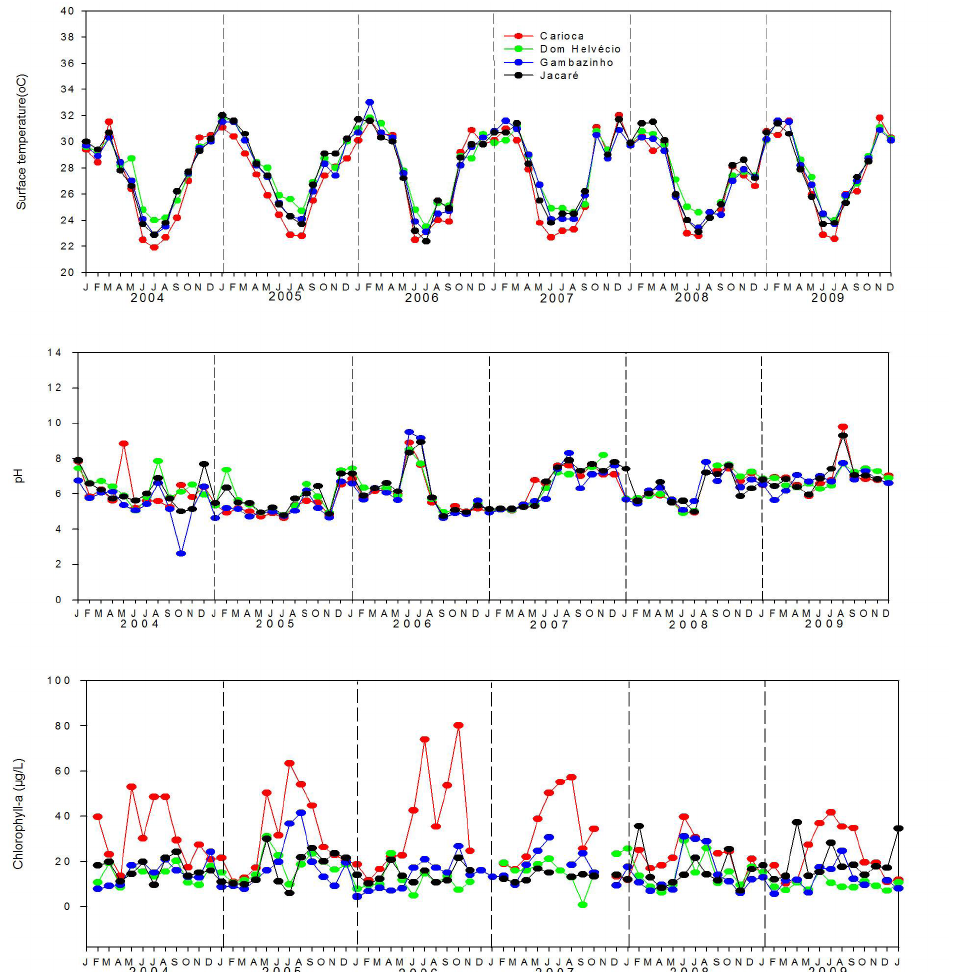
Figure 3. Time series of water temperature, pH, and chlorophyll-a illustrating different degrees of temporal coherence. Notes: The synchronicity for the variables is: water temperature= 0.97; pH= 0.78; chlorophyll-a=